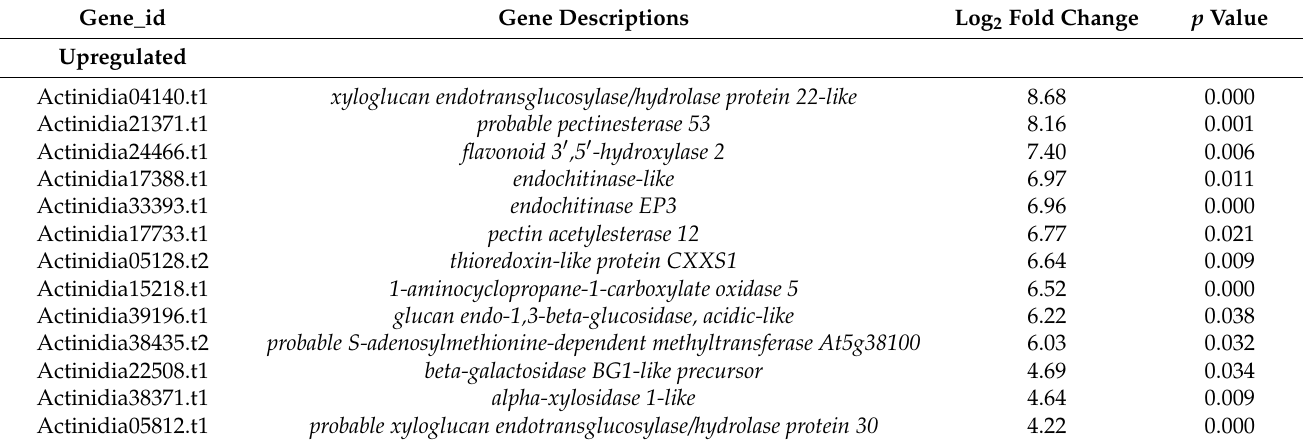
Table 3. List of DEGs exclusive to green ‘Hayward’ kiwifruit in the comparison of ethylene treated vs.